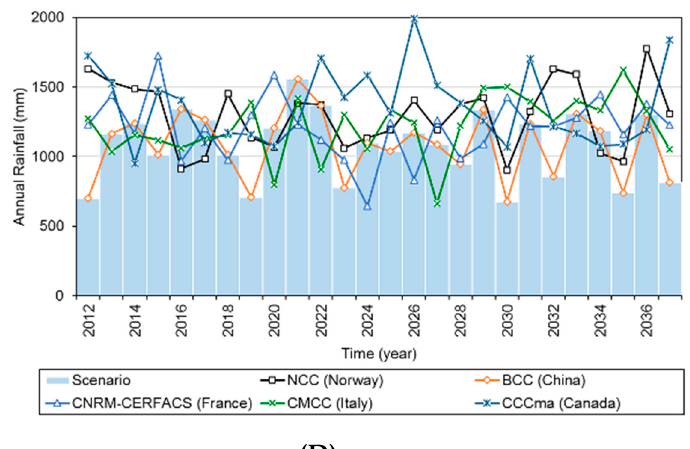
Figure 4. Prediction of ( A ) food consumption rate, ( B ) food production rate, ( C ) water and energy consumption rate, and ( D ) annual rainfall for the study area (Korea).